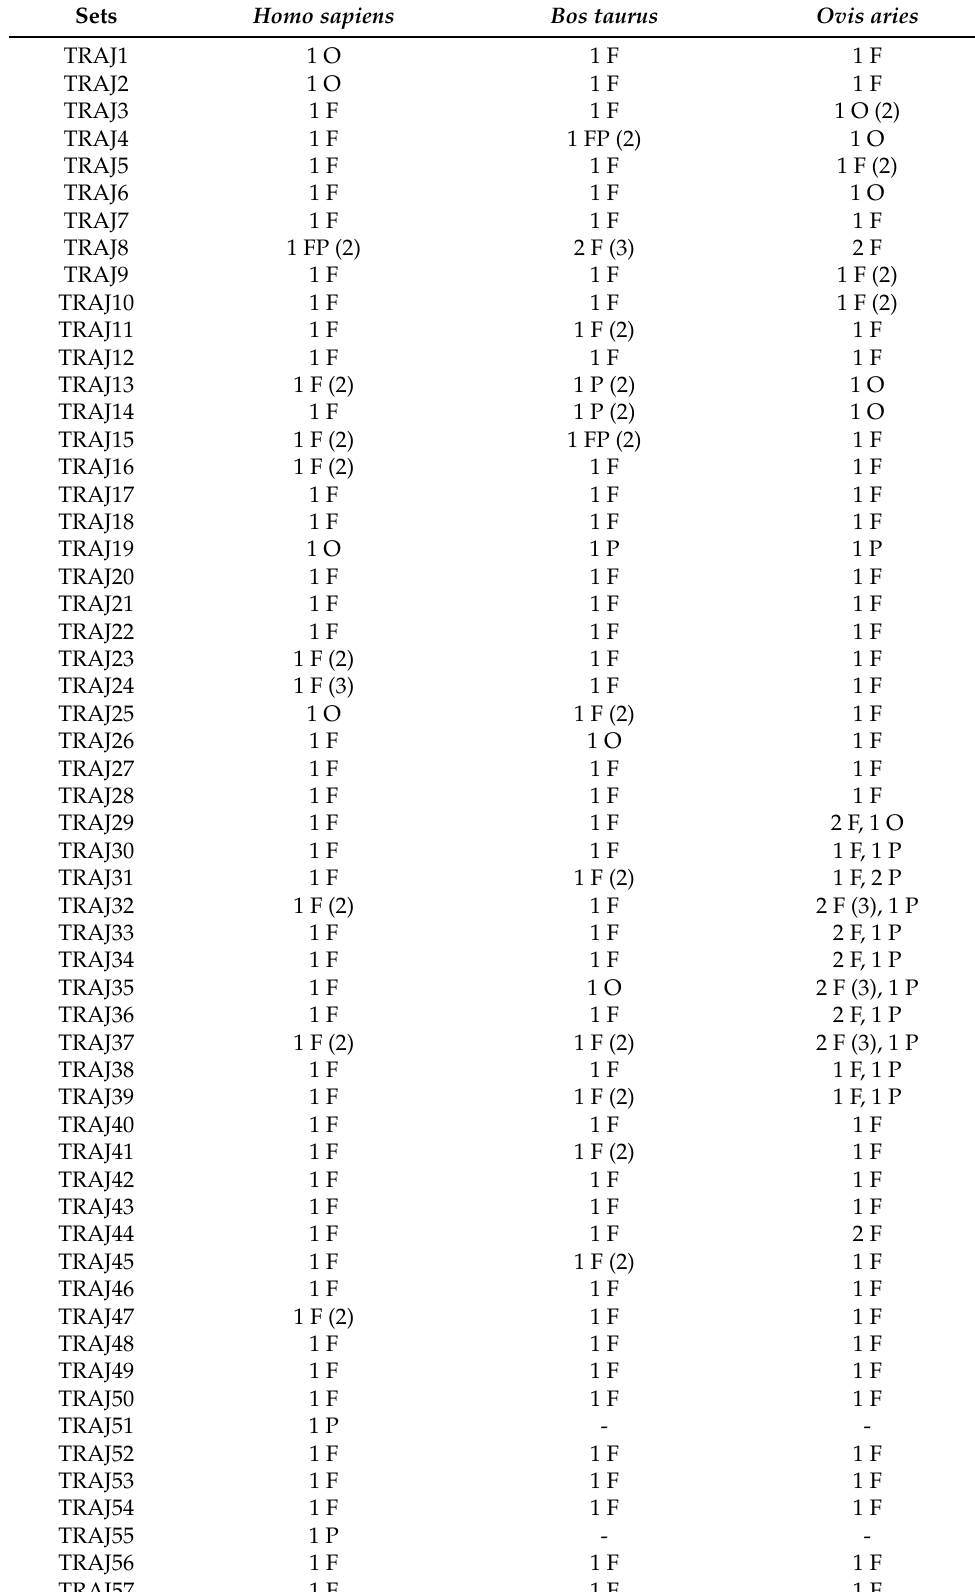
Table 4. IMGT Potential germline repertoires of the TRAJ sets in human ( Homo sapiens ), bovine ( Bos taurus ) and sheep ( Ovis aries ). Sets Homo sapiens Bos taurus Ovis